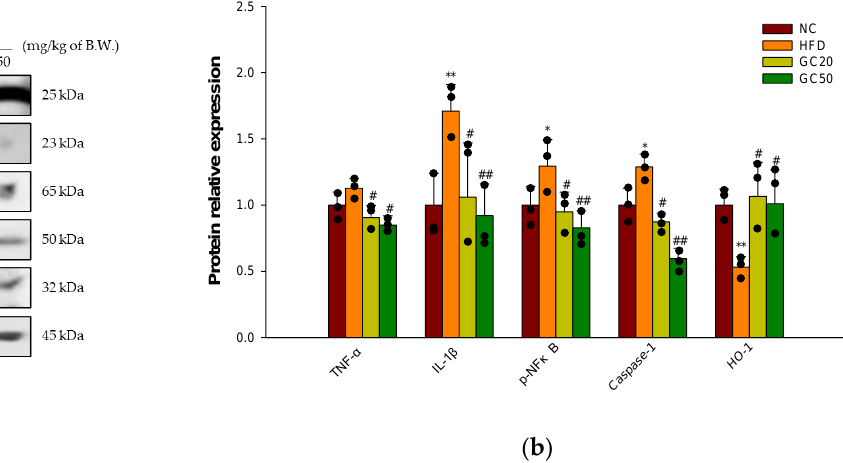
Figure 11. Protective effect of 80% ethanolic extract from Gimcheon 1ho (GC) cultivar walnut ( Juglans regia ) on HFD-induced neuroinflammation in mice brain tissues: ( a ) representative Western blots for total protein and expression; ( b ) protein expression levels of TNF- α , IL-1 β , p -NF κ B, caspase-1, and HO-1. Results shown are mean ± SD ( n = 3). Data are statistically represented with * = significantly different from the NC group, and # = significantly different from PM group; * and # p < 0.05, ** and ## p < 0.01. Bold line indicates mean.